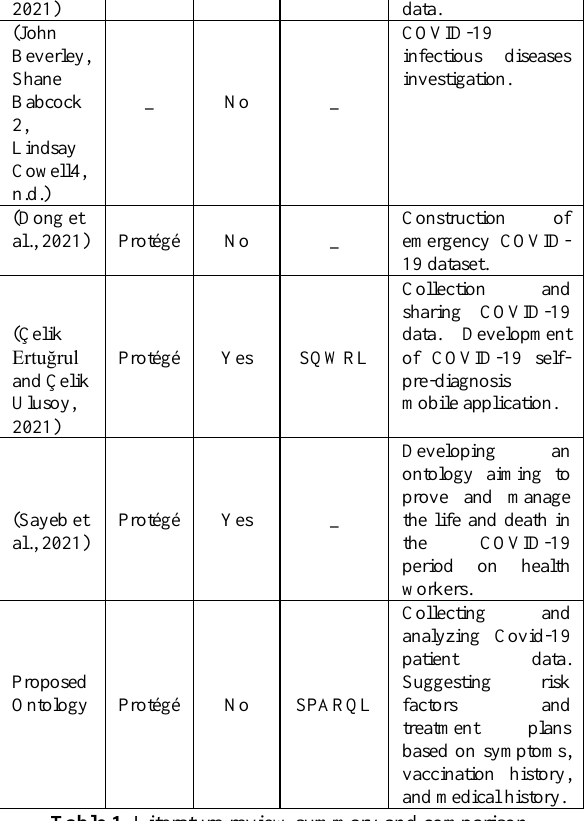
Table 1. Literature review summary and comparison